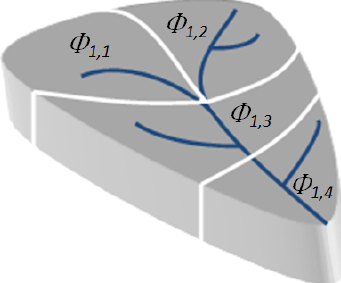
Fig. 2. Typical parameter set up for a semi-distributed model. Every 8 i,j stands for one parameter value ( i = parameter, j =